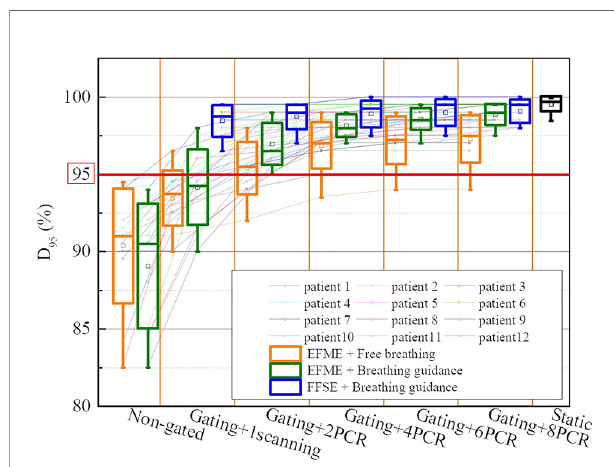
FIGURE 5 | Boxplots of the clinical target volume (CTV) dose coverage D95 over all cases of static, free-breathing, and breathing guidance maneuvers in the combination with gating and phase-controlled rescanning (PCR) methods delivered in the extended fl attop with multi-energy (EFME) and fi xed fl attop with single-energy (FFSE) synchrotron operation modes. The box plots represent one SD, the bands in the boxes are medians, and the extremes are the maximum and minimum values for each dataset.